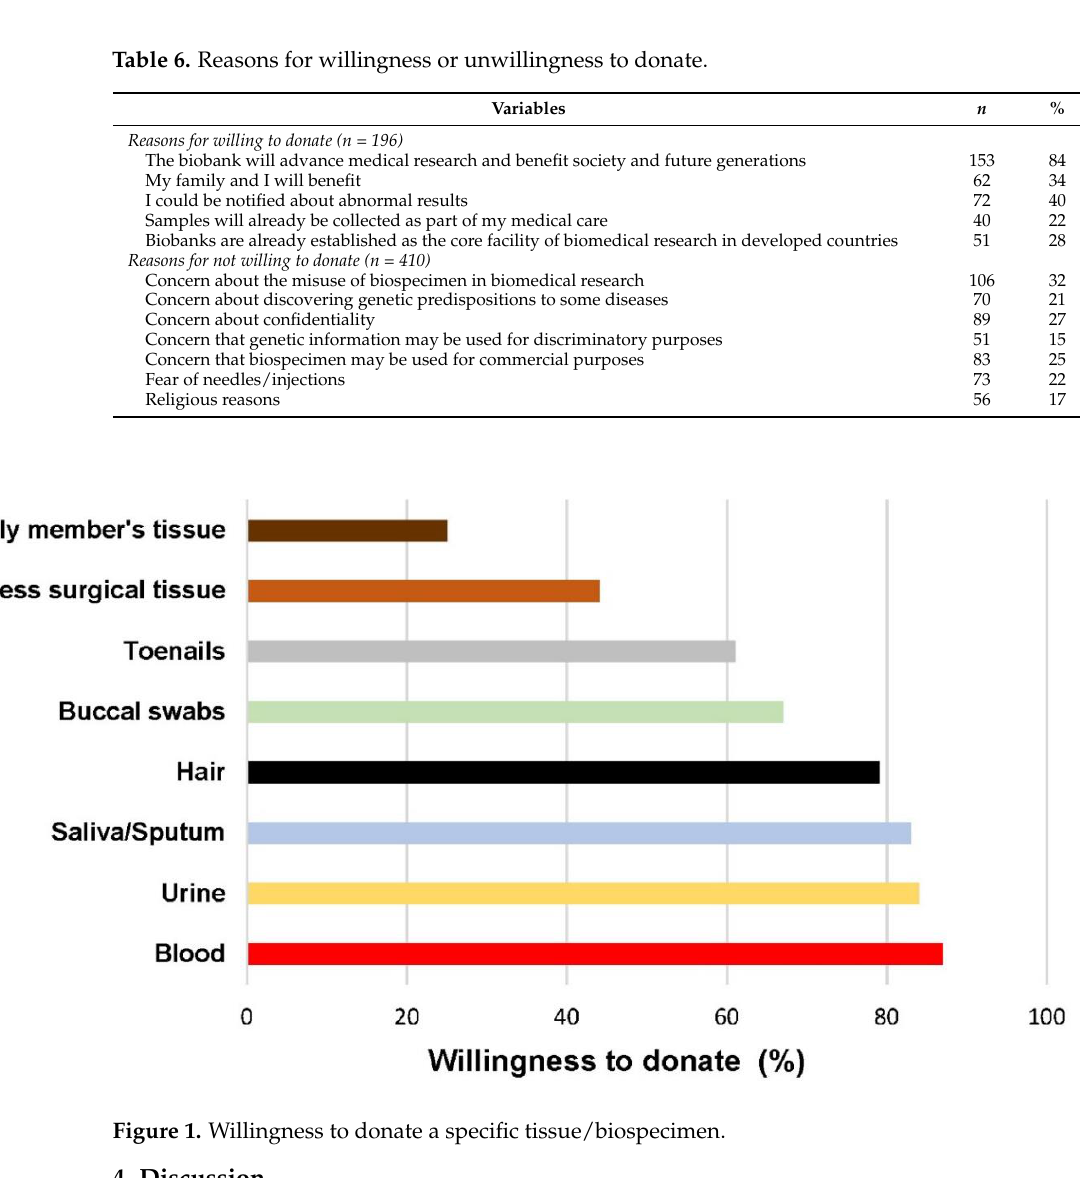
Table 6. Reasons for willingness or unwillingness to donate.